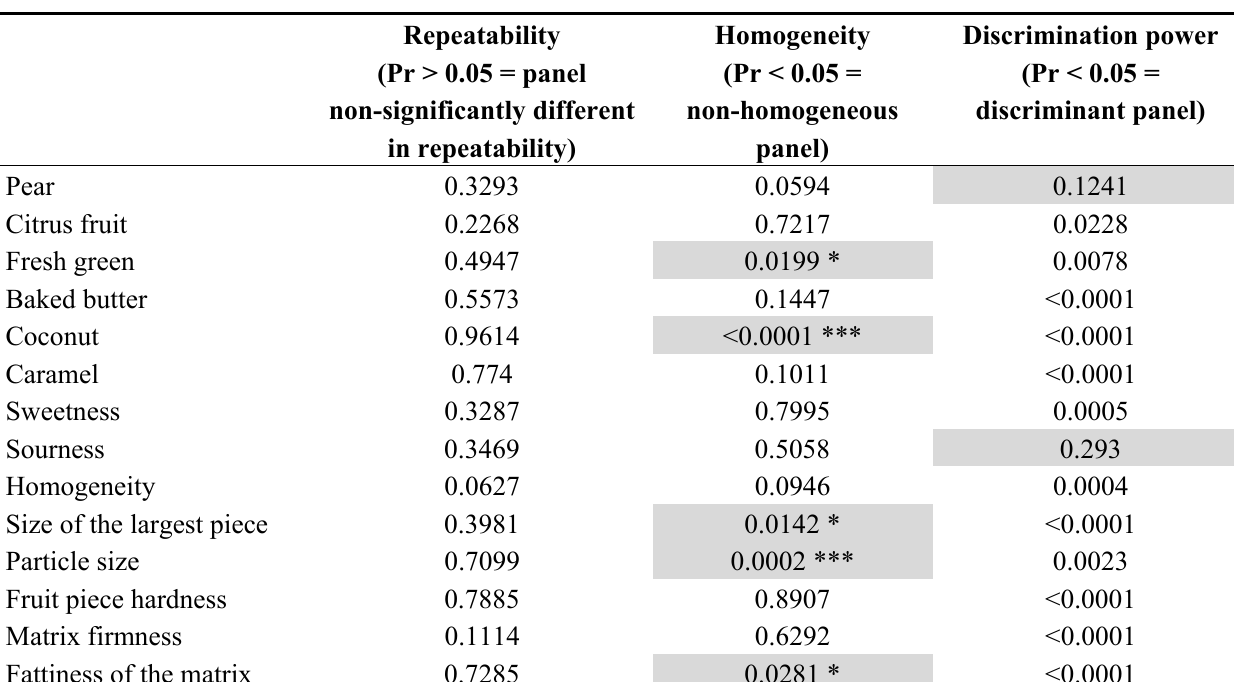
Table 6. Panel performances determined on profile data and represented by probability values calculated from analyses of variance (Repeatability: ANOVA one factor Repetition per attribute; Homogeneity: ANOVA attribute = Product + Panelist + Product x Panelist; Discrimination power: ANOVA attribute = Product + Panelist + Product x Panelist). Shaded cells indicate that the panel is significantly not reliable for this